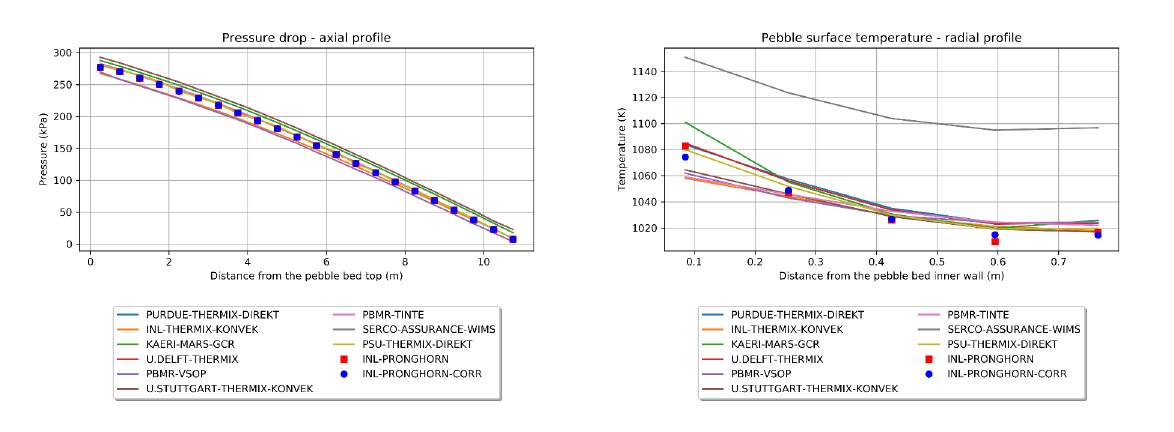
Figure 14: Pressure Drop - Axial Profile Comparison